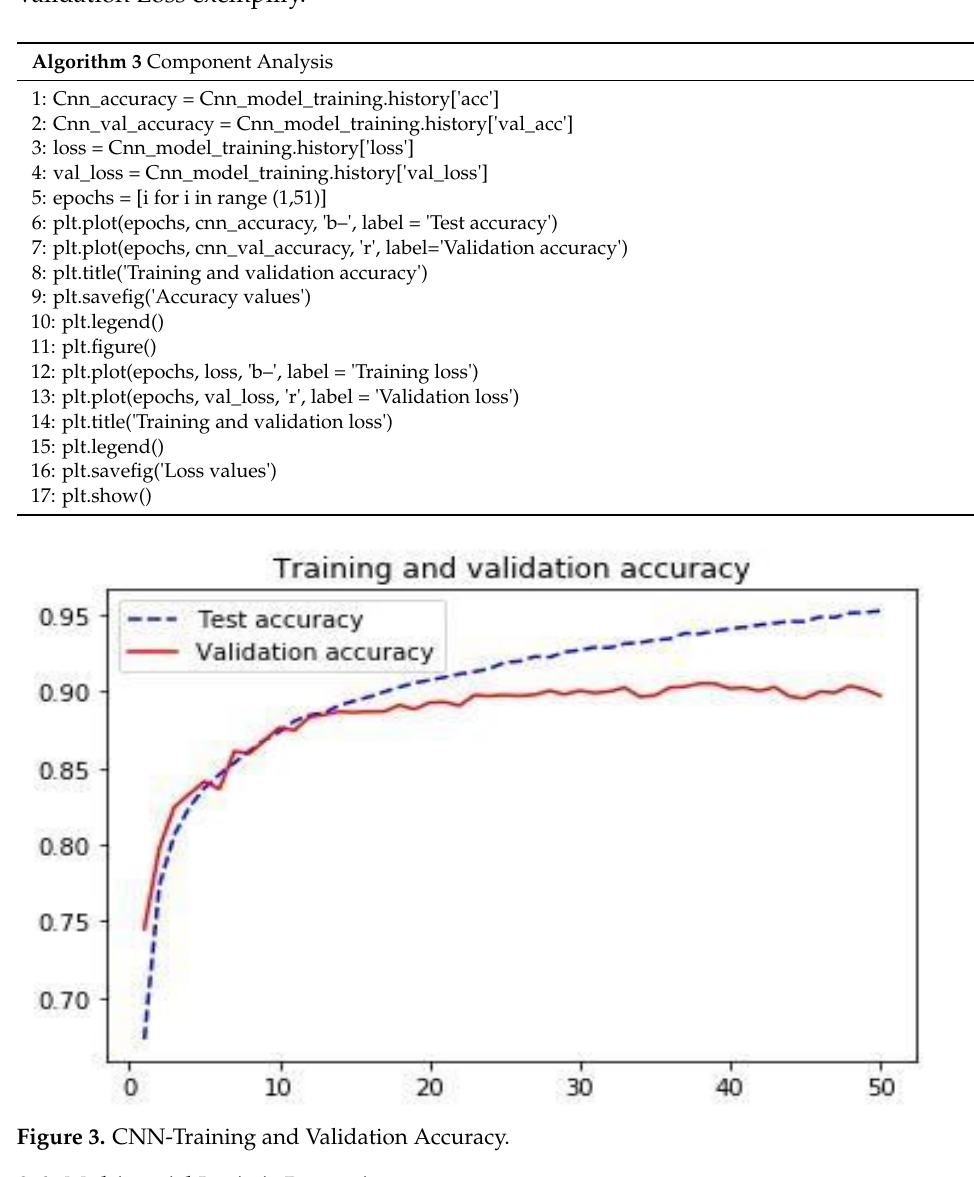
Algorithm 3 Component Analysis